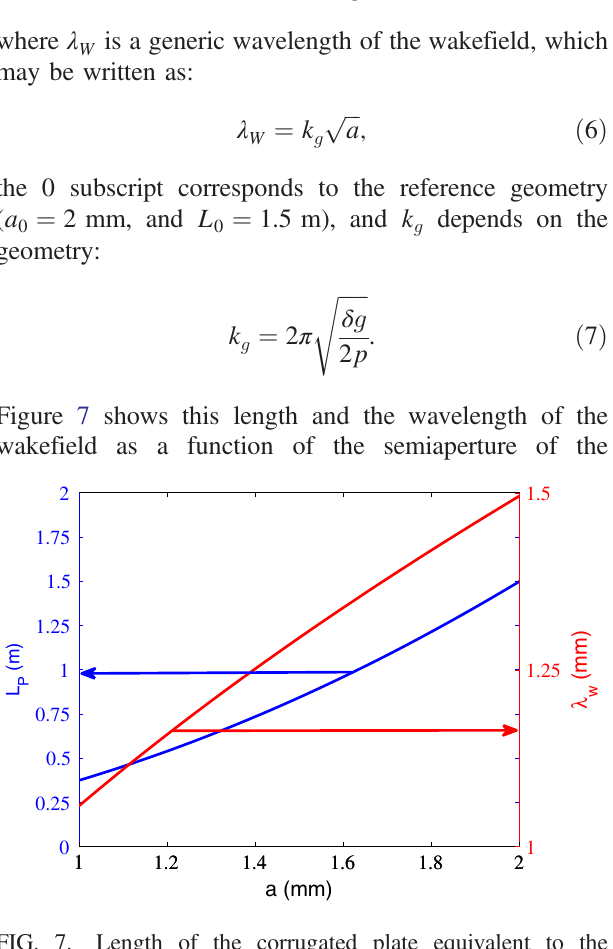
FIG. 6. Time (top plot) and energy (bottom plot) separation among the subpulses assuming different phases upstream of BC1 ( ϕ 1 ) and between BC1 and BC2 ( ϕ 2 ).